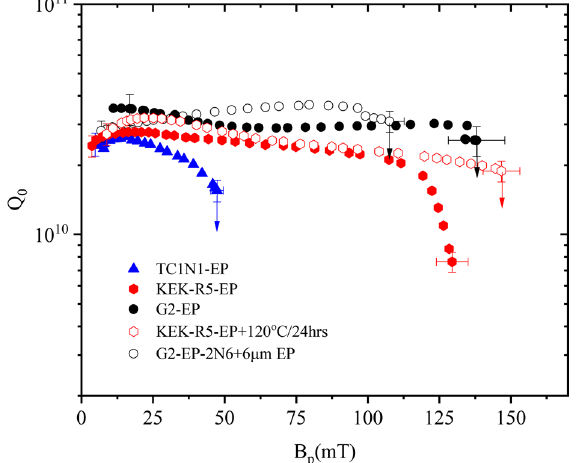
ð T Þ measured in electropolished cavity G2 for FIG. 6. R s cooldowns with Δ T > 4 K with different applied dc magnetic field values prior to cooldown. Solid lines are fits with Eq. (1).